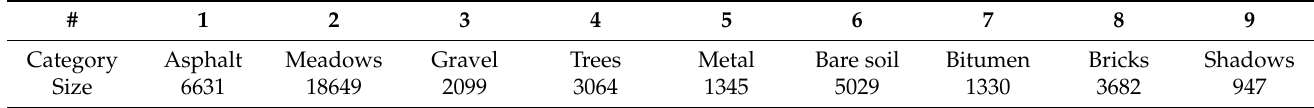
Figure 2. False-color composite map and ground truth information of the Pavia University data set: ( a ) False-color com- posite image; ( b ) Ground truth image. Table 1. Land category and sample size of Pavia University data set. Table 1. Land category and sample size of Pavia University data set.